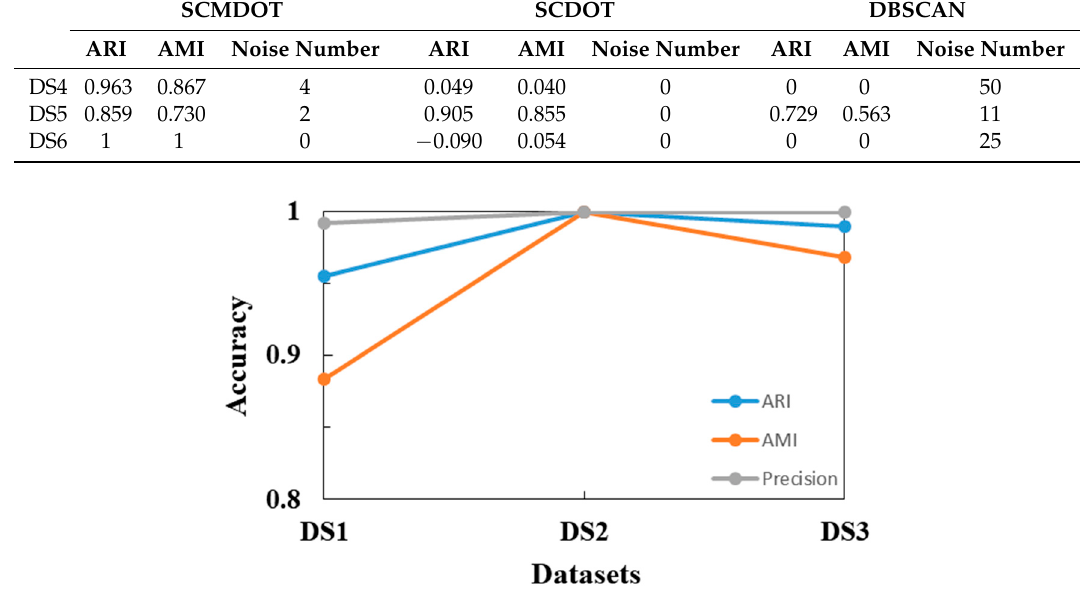
Figure 7. The accuracy values of SCMDOT in Experiment 1 .